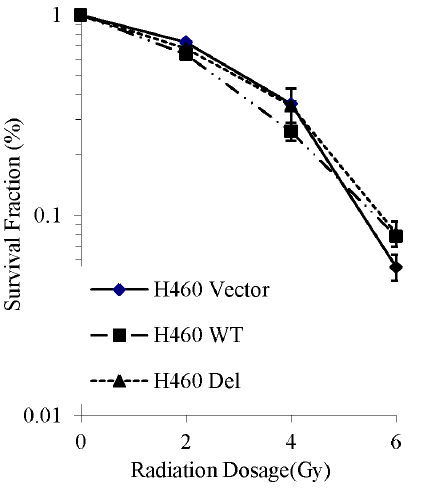
Figure 5. Overexpression of novel p53 mutation does not confer radiation resistance. p53 variant does not affect radiation resistance in the presence of WT p53. Transfection with WT p53 results in slightly decreased survival after irradiation with 4 Gy, but there is no difference in survival after exposure to 6 Gy. DER: (SF=0.2); WT: 1.05 (p=0.074); DEL: 0.97